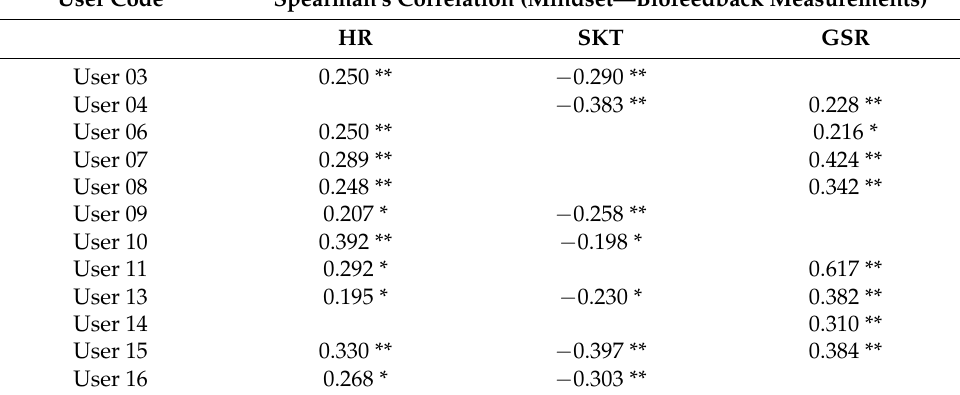
Table 2. Significant correlation coefficients between the Mindset device and the biofeedback device measurements for each